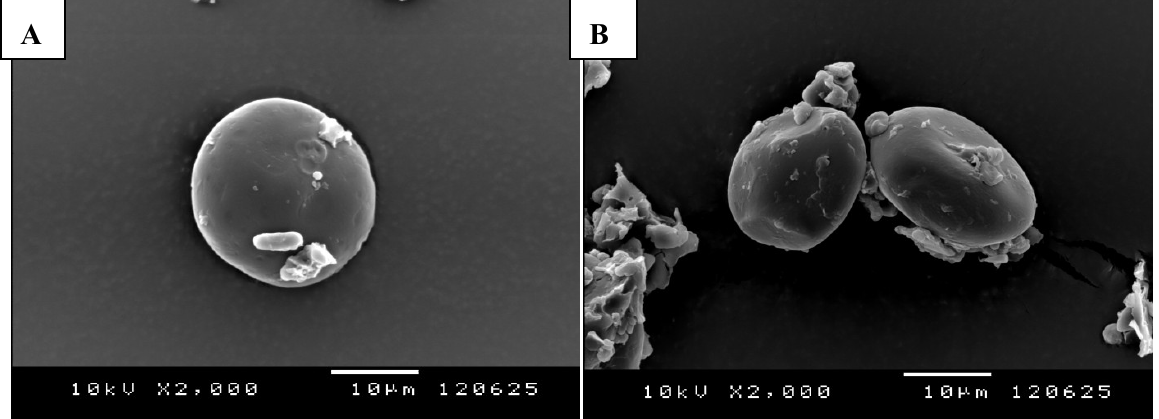
Figure 1. Scanning electron microscope images of starch granules of “Eureka” a 2-row-winter-feed barley cultivar ( A ) and “Vienna” a 2-row-summer-feed barley cultivar ( B )